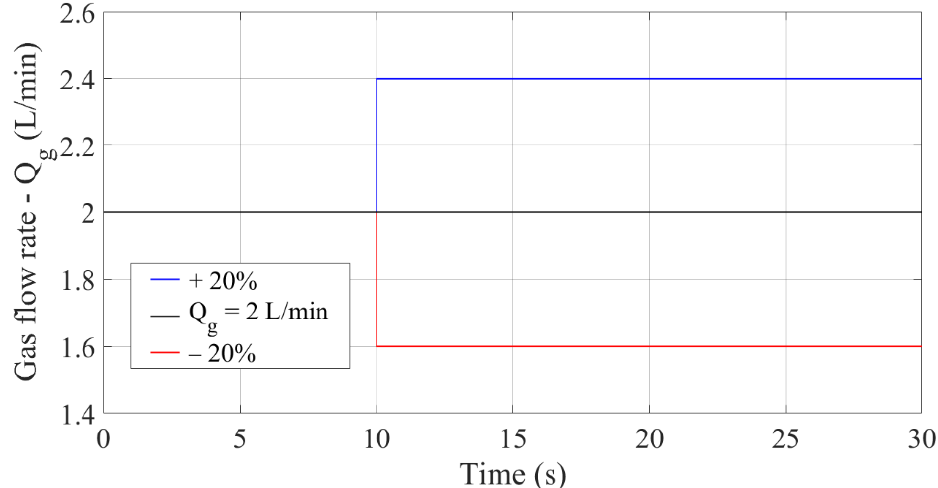
Figure 13. Step signal for intel flue gas scenario (increase/decrease).